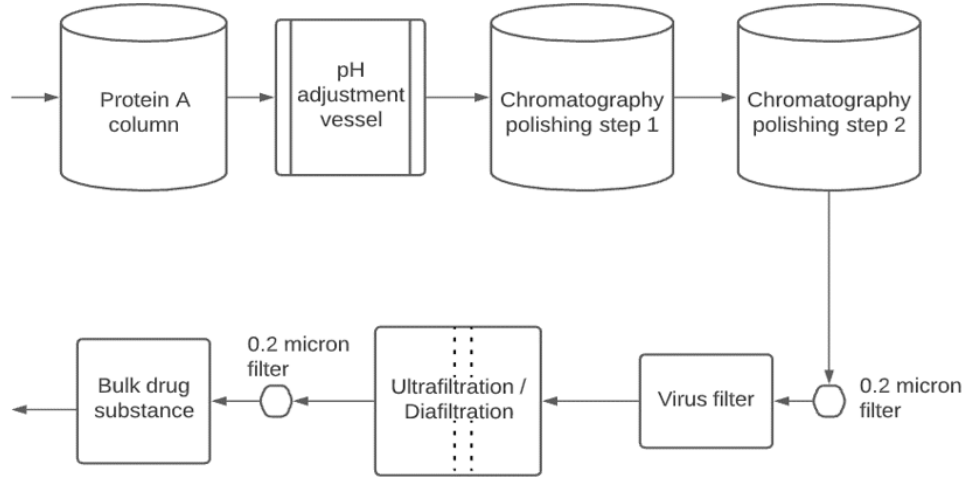
Figure 1. Downstream purification of mammalian cell-derived biotherapeutics. Frequently, two polishing steps are used to remove the remaining impurities and prod- uct variants/aggregates [17]. Resin- or membrane-based chromatography (ion exchange or hydrophobic interaction chromatography) is frequently used. The polishing steps remove impurities such as DNA, host cell proteins (HCP), and product aggregates [2]. Typically, all streams and buffers which enter the purification process are passed through sterilizing grade (0.22 µ m pore size) filters to reduce